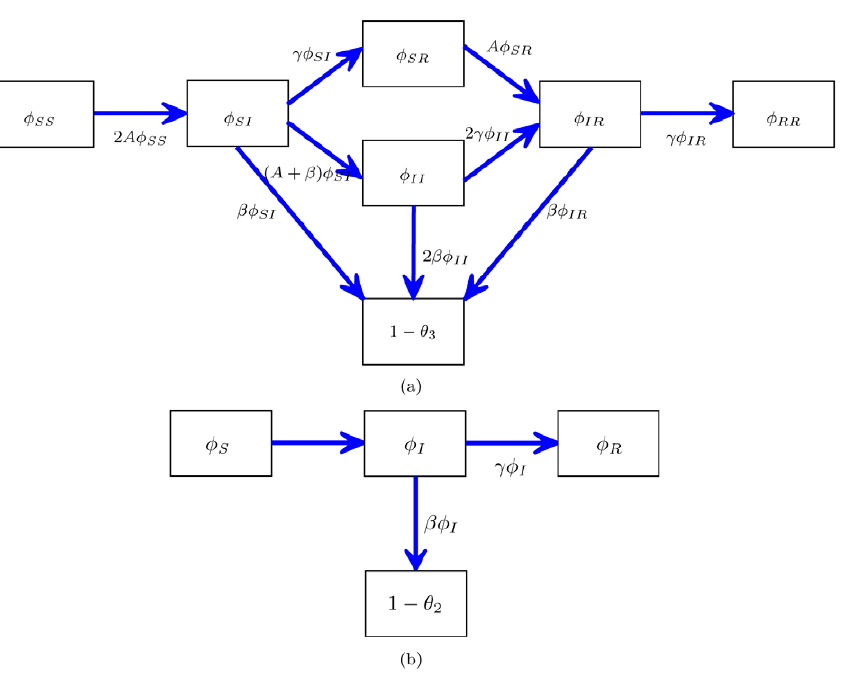
Figure 1. A schematic of the system of equations 7–8. A: The flux between the probabilities that a node u is connected to a triangle with all possible configurations as well as the probability that a node v = u in the triangle has transmitted to u . B: The flux between the probabilities that a node u is connected by a line to a node v that is susceptible, infectious, recovered, and the probability that v has transmitted to u .